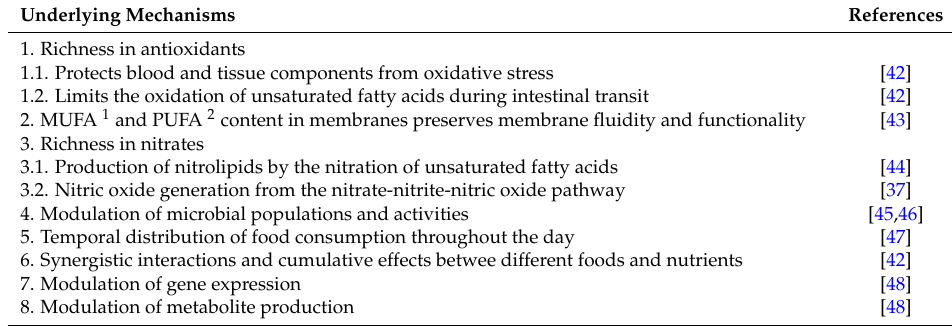
Table 1. Underlying mechanisms of the beneficial effects of the Mediterranean diet on cardiovascular diseases (CVD).